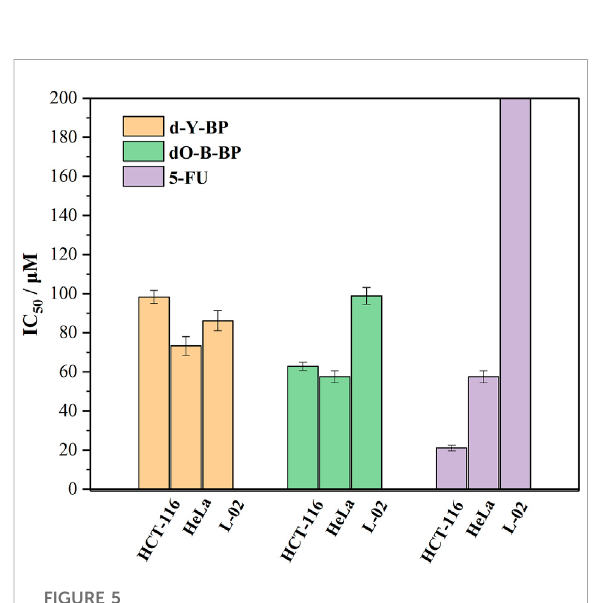
FIGURE 5 The half-maximum inhibitory concentration (IC 50 ) of d/dO- Y-BP and 5-FU on HCT-116, HeLa, and L-02